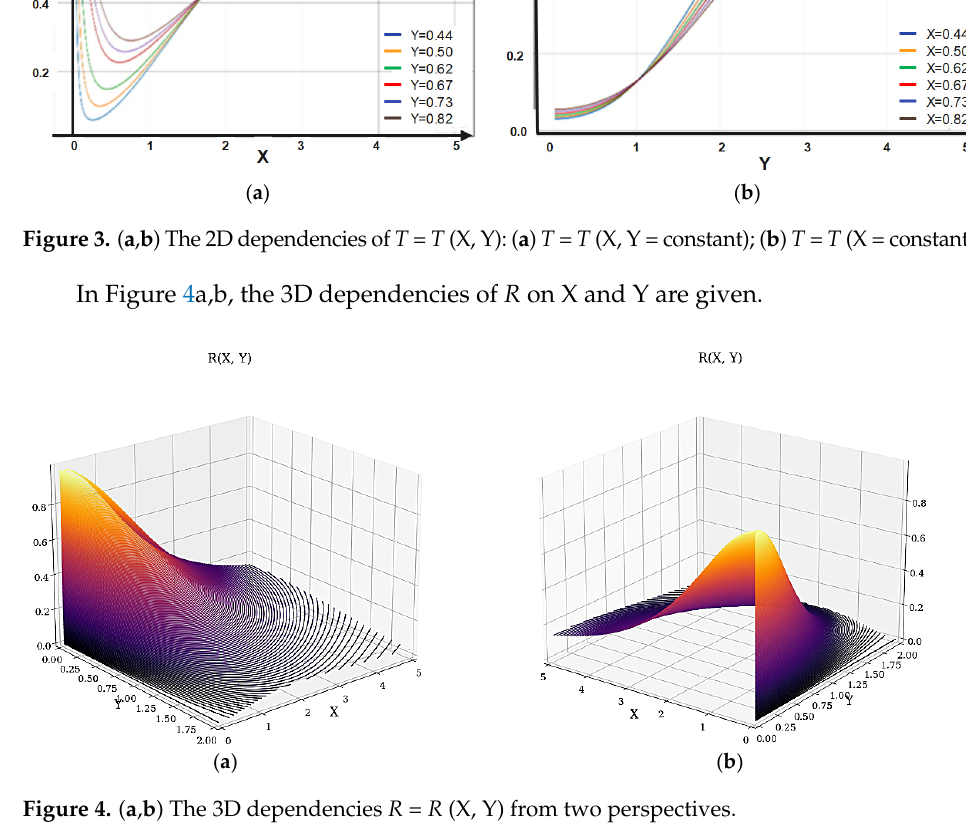
Figure 4. ( a , b ) The 3D dependencies R = R(X,Y) from two perspectives. In Figure 5a,b the 2D dependencies of R on X and Y are given.